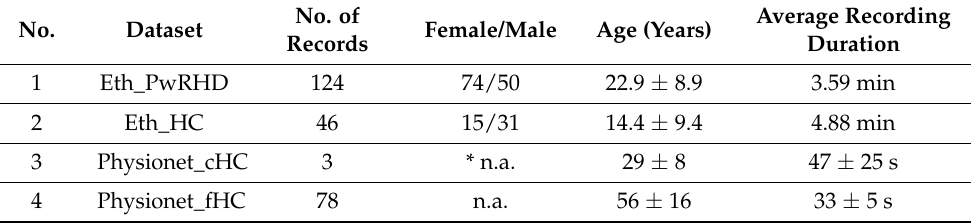
Table 1. Summary of the Ethiopian heart sound dataset collected from 170 subjects (~670 min of recordings), TASH, Addis Ababa, Ethiopia (row 1 and 2), and additional HC data from